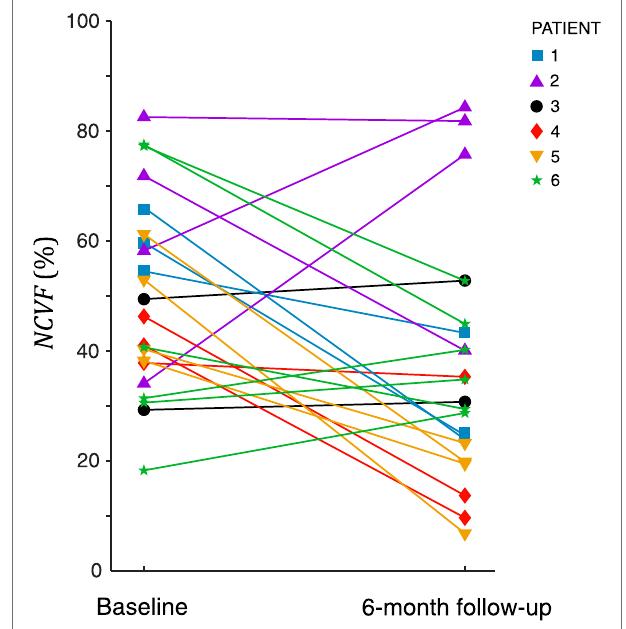
FIGURE 10 | Estimated NCVF values at the baseline and 6-month follow-up in all 22 segments with LGE > 25% at 6-month follow-up. Different symbol – colorcombinationsindicatedifferentpatients,asshowninthelegend. The majority of segments (68%) demonstrated a reduction of the NCVF at 6-month follow-up with respect to the baseline. Results for patient 1 and patient2arealsoshownin Figures8 , 9 ,respectively.Results forpatients3 – 6 are shown in Supplementary Section 11.3